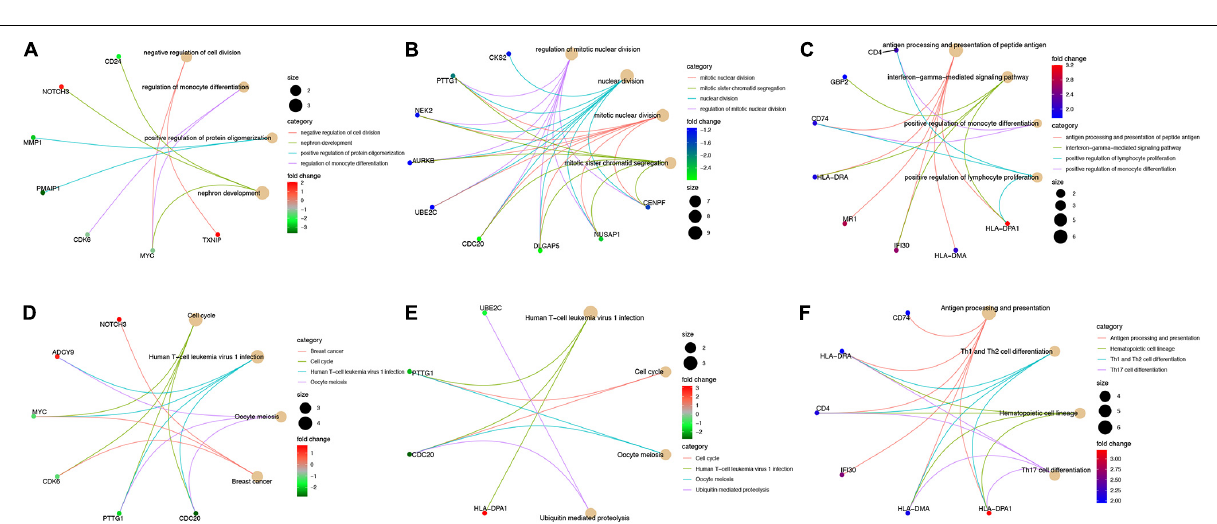
FIGURE 8 | Interactive genes of hub-genes were filtered by a Pearson correlation coefficient > 0.5 and GO (A–C) and KEGG pathway (D–E) analyses were performed for these genes. GO and KEGG analyses for (A,D) interactive genes of MYC ; (B,E) interactive genes of KIF20A ; (C,F) interactive genes of HLA-DRA and HLA-DPA1 . Cut off = adjust P < 0.05, the top four are shown in